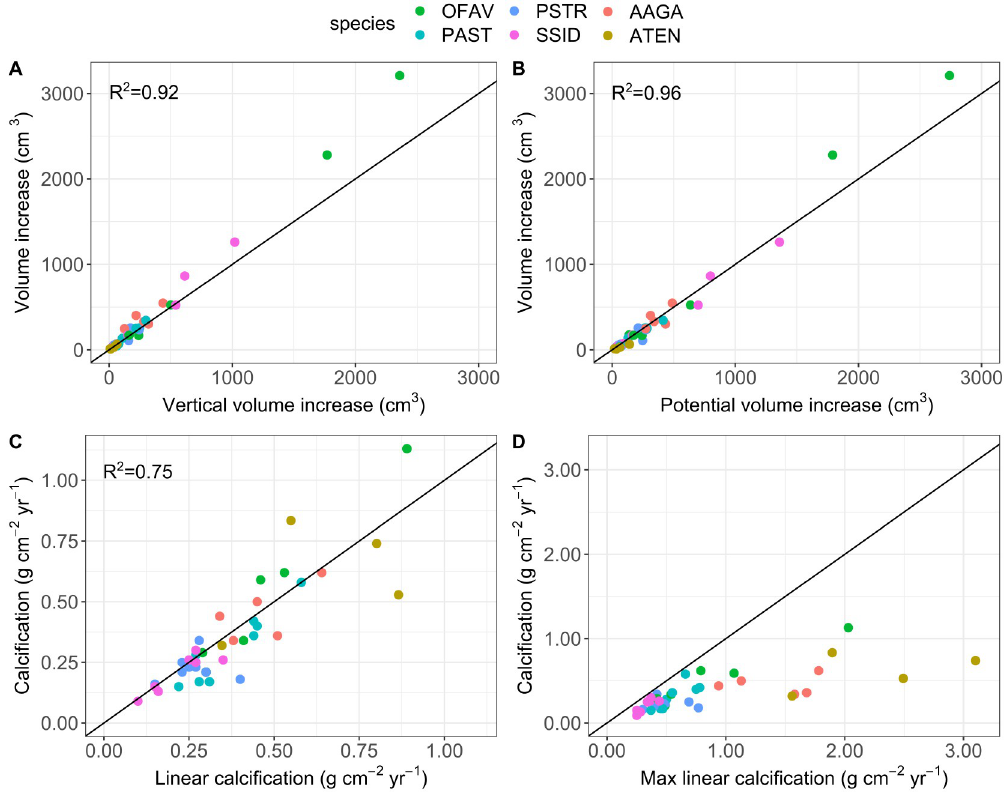
Fig 4. Comparison of different methods to calculate volume increase and calcification rates. Each point represents one colony (n = 38) of one of six species (OFAV: Orbicella faveolata , PAST: Porites astreoides , SSID: Siderastrea siderea , PSTR: Pseudodiploria strigosa , AAGA: Agaricia agaricites and ATEN: Agaricia tenuifolia ). Y-axes : Best estimate volume increase (A and B) was measured directly between overlying surface meshes and multiplied by skeletal densities to yield best estimate calcification rates (C and D). X-axes : A) Vertical volume increase was calculated using the 2.5D volume command in CloudCompare. B) Initial surface area was multiplied with average linear extension to yield potential volume increase, and then C) multiplied by skeletal densities to yield linear calcification. D) Average linear extension was replaced by maximum linear extension rates to yield maximum linear calcification. R 2 in plots indicates the fit of data to the ideal line of prediction (y =